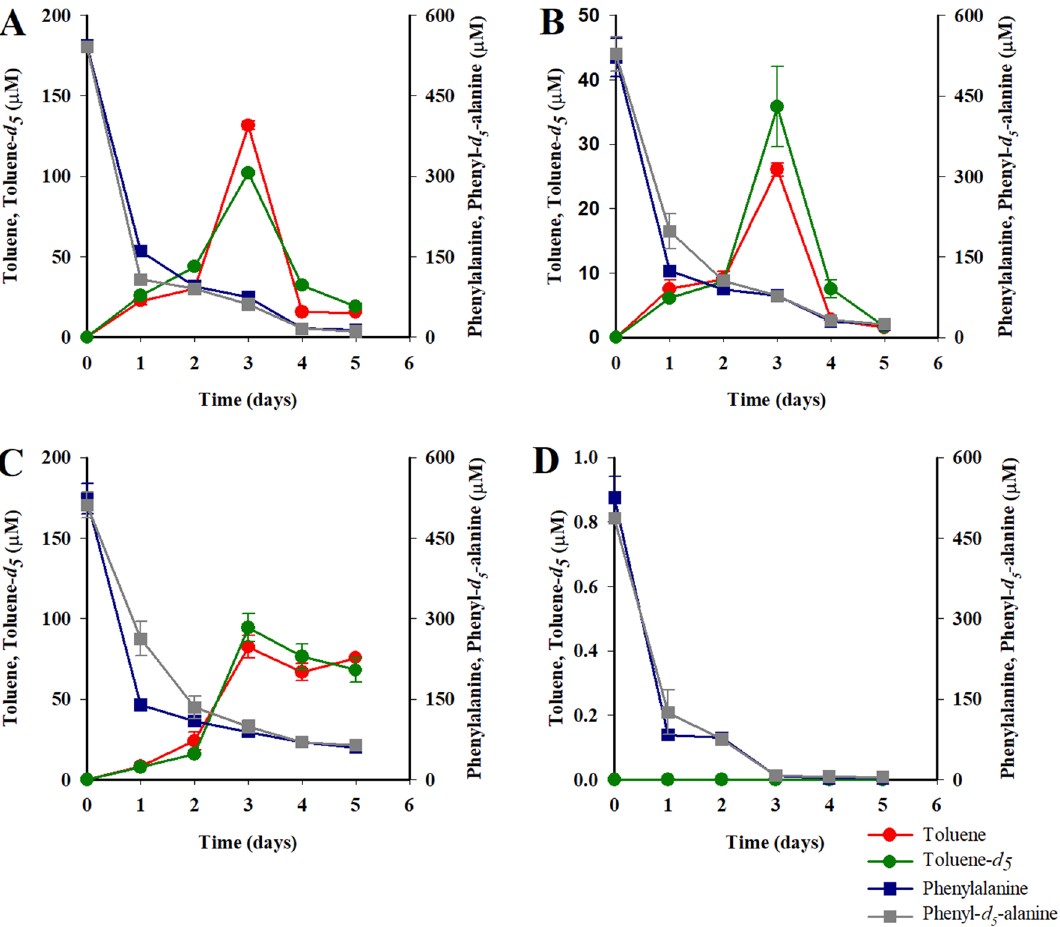
Figure 3. Time course of production of toluene and toluene- d 5 , and decay of phenylalanine and phenyl- d 5 - alanine in ( A ) anoxic-1 incubations (with excess nitrate), ( B ) anoxic-2 incubations (with excess sulfate), ( C ) anoxic-3 incubations (without electron acceptor added), and ( D ) oxic